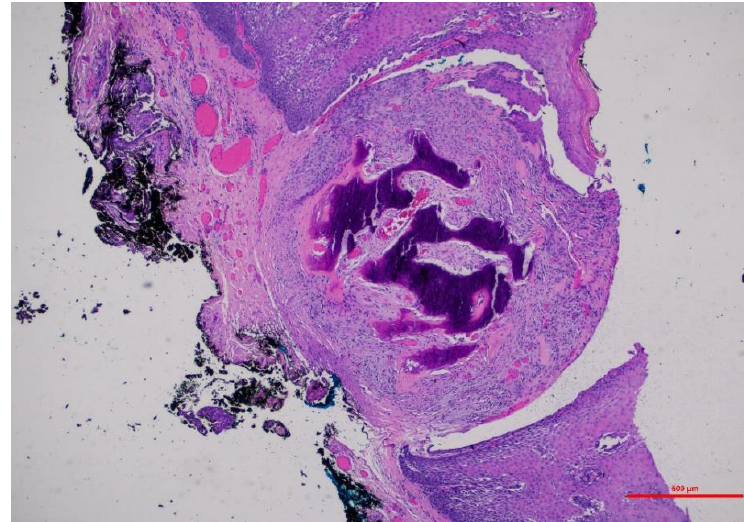
Figure 2. Pathology H&E stain (4×) show hyperplastic mucosa with a superficial, circumscribed focus of metaplastic bone formation.